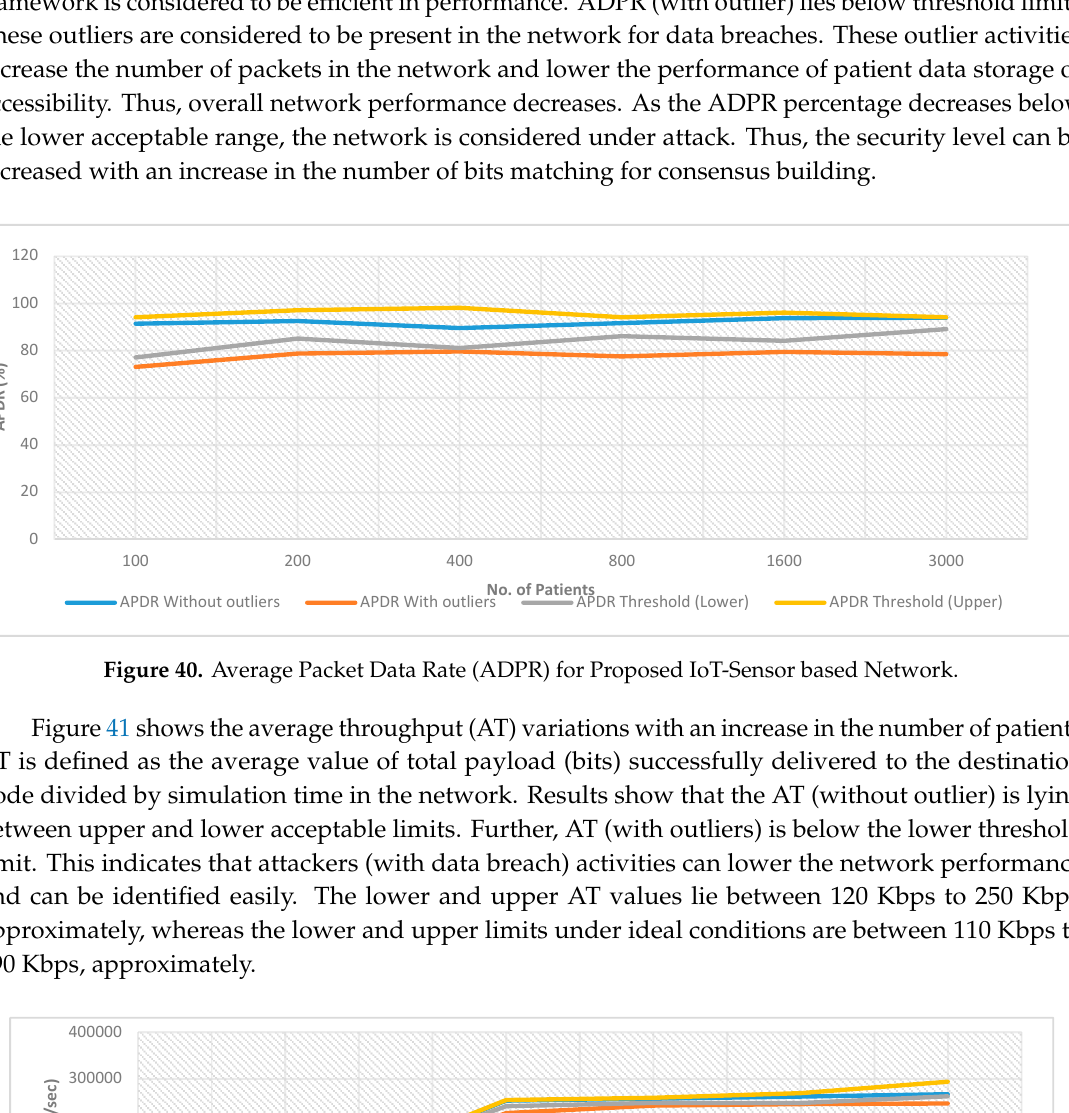
39 of 43 Figure 39. AnyLogic Patient-Doctor Simulation 2D Model in Execution (top viewpoint). (5) Proposed Healthcare 4.0 Processes-based Network’s Performance Analysis Figure 40 shows the Average Packet Delivery Rate (APDR) with an increase in patients in the